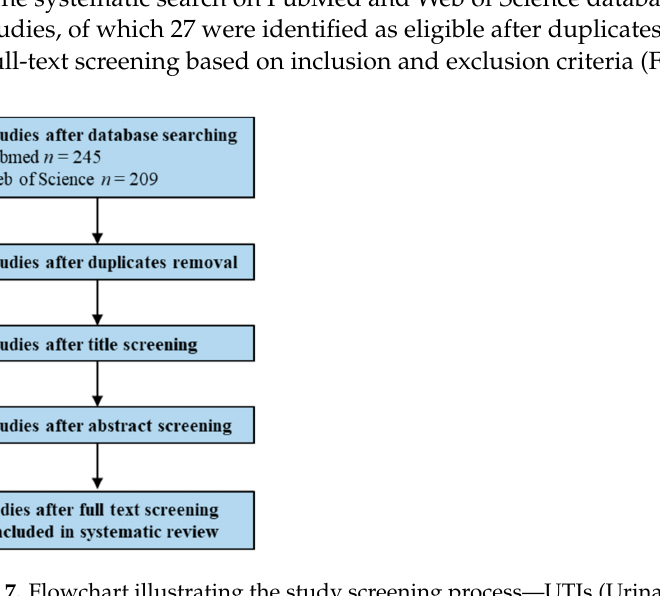
Figure 7. Flowchart illustrating the study screening process—UTIs (Urinary Tract